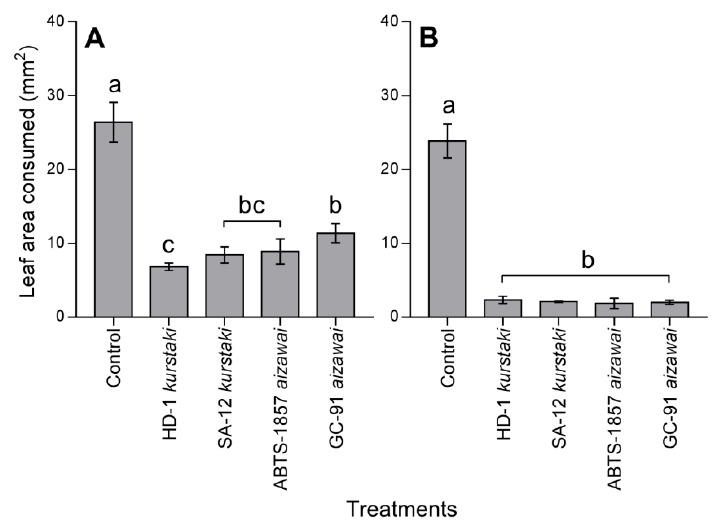
Figure 2. Leaf area consumed by Euprosterna elaeasa caterpillars exposed to Bacillus thuringiensis strains (LC 50 ( A ) and LC 90 ( B ) estimated values). Treatments (mean ± SEM) differ at p < 0.05 (Tukey’s mean separation test).